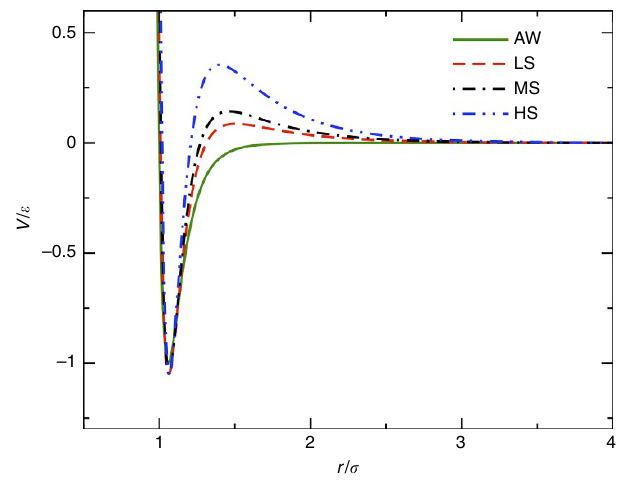
Figure 1 | Interaction potentials. The curves correspond to LS, MS, HS potentials considered here as a function of the interparticle distance r , plus the purely attractive well case (AW) from ref. 58. The corresponding values of the parameters A 1 and A 2 , and V ( r max ) are listed in Table 1.